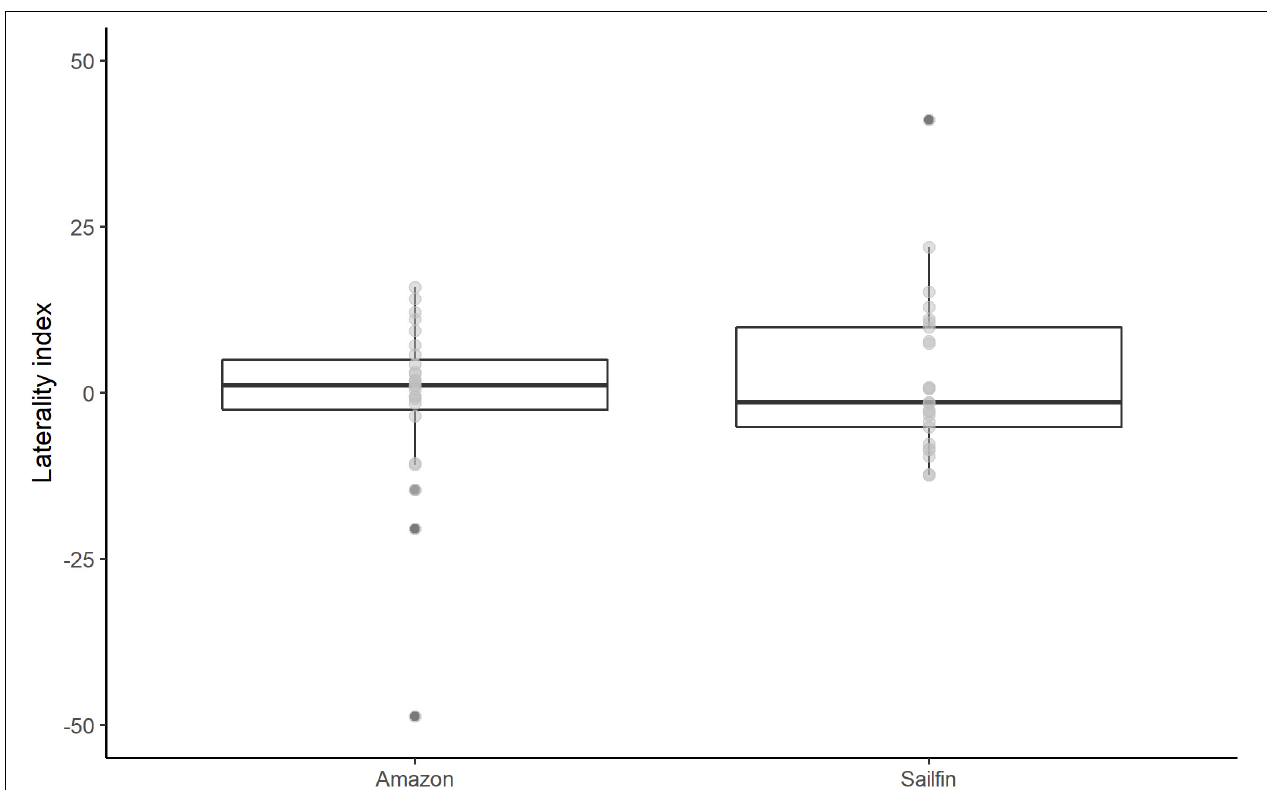
FIGURE 4 | Boxplots (, median; (cid:3) , 25–75th percentile; outliers in dark gray; raw data in light gray) of laterality index scores for Amazon and sailfin mollies. Neither species exhibited a significant eye bias (one-sample t -tests), nor did the species clearly differ in their average laterality index score (two-sample t -tests).